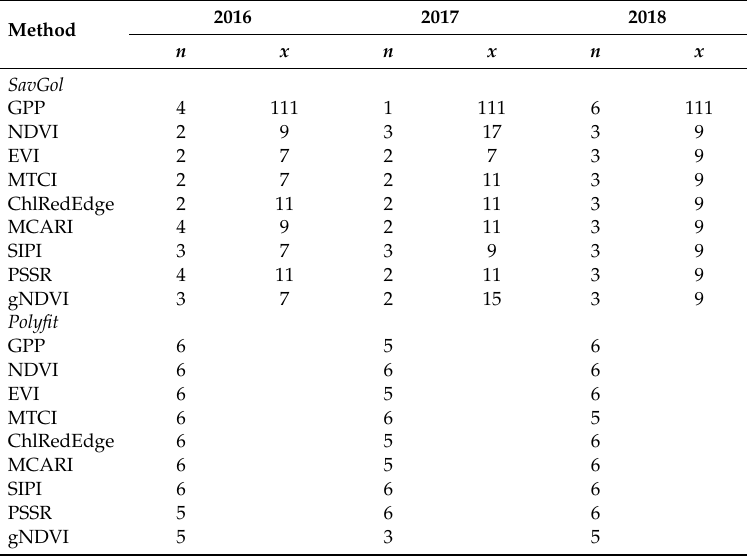
Table 2. Parameters used for Savitzky–Golay (SavGol) and polynomial (Polyfit) methods for filtering time-series of Gross Primary Productivity (GPP) and VIs (see VIs definitions in Table 1) per each year. n —degree of polynomial function; x —data points in the moving window used for the SavGol